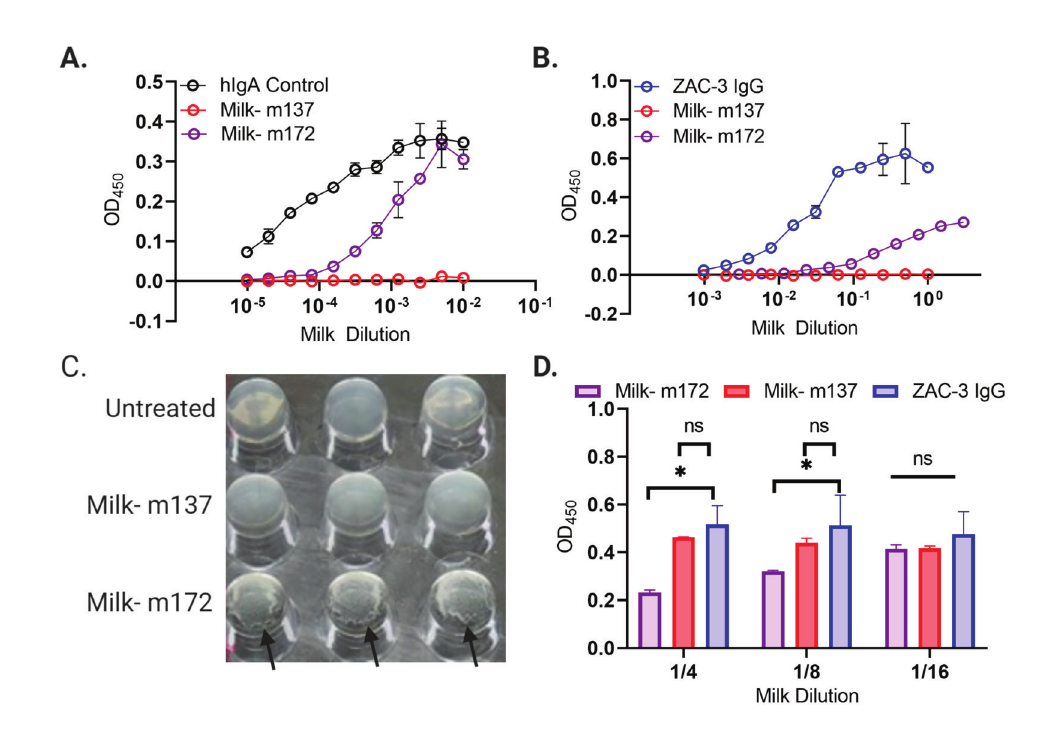
Figure 2. Transgenic Mice Secrete ZAC-3 hIgA that is Capable of Binding to and Agglutinating V. cholerae O1. (A) IgA sandwich ELISA to determine the concentration of hIgA in milk samples. In com- parison to control human IgA from colostrum, milk from m172 exhibited above background binding to anti-human IgA ELISA plates, while milk from m132 did not. (B) Whole cell ELISA coated with V. cholerae O395 cells. Milk from m172 exhibited above background binding to V. cholerae O395 while milk from m137 did not. ZAC-3 IgG (Diluted 1:2 starting at a concentration of 10 µg/mL) was included as a control for V. cholerae binding. (C) Mid-log phase V. cholerae O395 were mixed with a 1:1600 dilution of milk from either m137 or m172 for 2 hours at 37 ° C and monitored for macroagglutination. Black arrows indicate where cells treated with milk from m172 aggregated at the bottom of the wells, suggesting an- tibody in milk can crosslink V. cholerae cells and cause them to settle out of solution. (D) Competition ELISA between ZAC-3 IgG and milk containing ZAC-3 hIgA from m172 or control milk. Plates coated with whole V. cholerae O395 cells were incubated for 1 hour with ZAC-3 IgG at 0.1 µg/mL, then milk from m172 or m137 was added at indicated dilutions for 1 hour. ZAC-3 IgG was detected and milk from m172, not m137, significantly inhibited binding of ZAC-3 IgG to whole V. cholerae cells, indicating that ZAC-3 hIgA can compete with ZAC-3 IgG for binding. Statistical significance was determined using 2-way ANO- VA followed by Tukey multiple comparison test, * P < 0.05. All data comprised at least 2 technical replicates that are representative of at least 2 biological